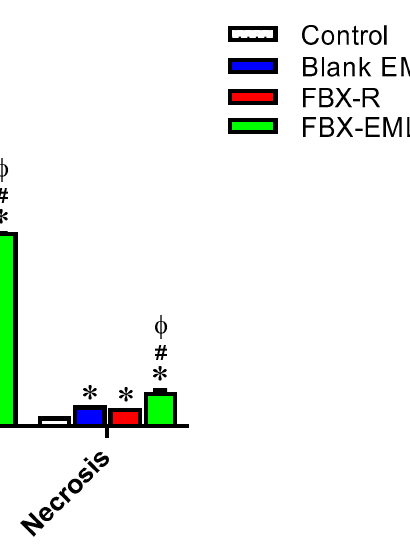
apoptotic or necrotic HCT 116 cells. Total = apoptosis + necrosis; Early = early apoptotic phase; Late = Figure 6. Impact of Blank EMLs, FBX-R, or optimized FBX-EMLs treatments on the percentage of